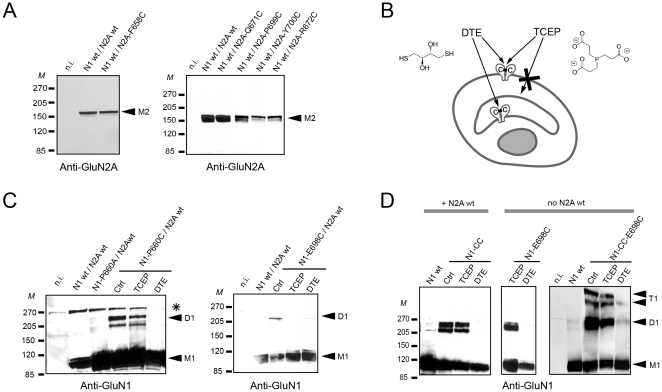
Intracellular and plasma-membrane pools of disulfide cross-linked receptors.(A) Immunoblots from Xenopus oocytes expressing either wt or GluN2A mutant receptors. (B) Schematic representation of a cell expressing intracellular and plasma-membrane pools of receptors with intersubunit disulfide cross-links. Because of their differential membrane permeability, the reducing agent DTE acts on both pools while the reducing agent TCEP acts solely on the cell surface pool. (C) Immunoblots from oocytes expressing either wt or GluN1 mutant receptors. (D) Immunoblots from occytes injected either with both GluN1 and GluN2A subunits or with the GluN1 subunit alone. M1 indicates the expected band position of the GluN1 monomer (∼110 kDa); M2, the GluN2A monomer (∼180 kDa); D1, the GluN1 homodimer (∼220 kDa) and T1 the approximate location of the GluN1 homo-trimer and/or homo-tetramer (>300 kDa). CC stands for mutations GluN1-N521C-L777C (in ABD intradimer interface). M stands for molecular weight marker and n.i. for non-injected oocytes. * indicates non-specific bands seen with the anti-GluN1 antibody.